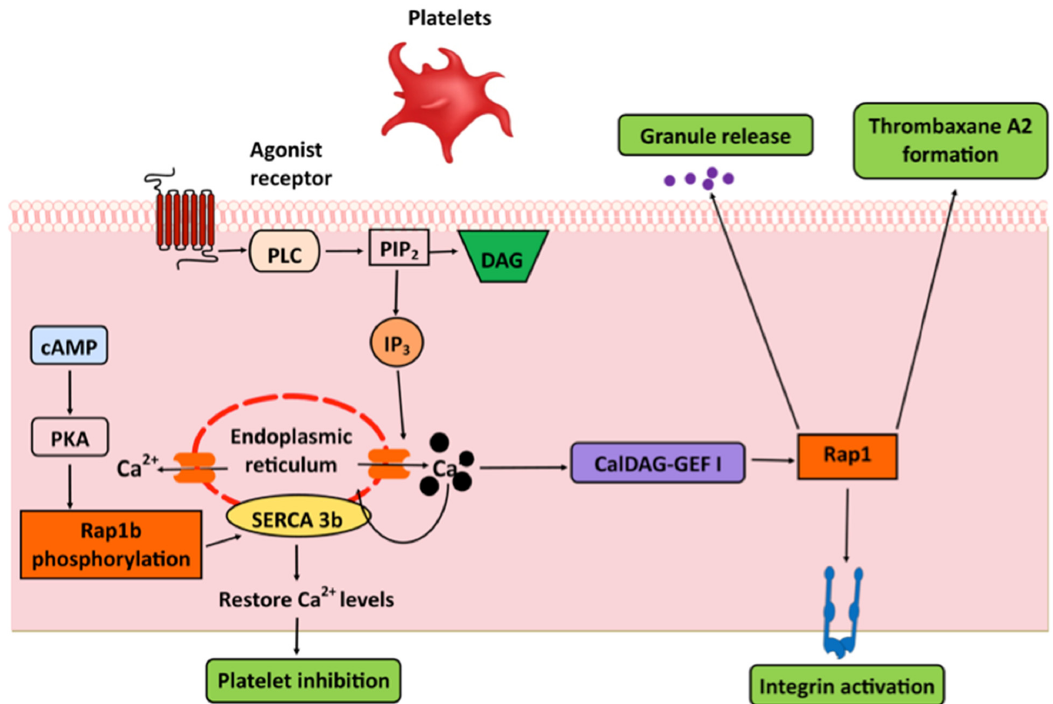
Figure 2. Rap1 and Ca 2 + cross-talk in platelet function. Downstream from agonist receptors, CalDAG-GEFI links the intracellular Ca 2 + rise with Rap1 activation, promoting integrin activation, thromboxane A2 formation and granule release. Rap1b physical interaction with sarco/endoplasmic reticulum Ca 2 + ATPase (SERCA 3b), regulated by phosphorylation, modulates Ca 2 + re-uptake and platelet